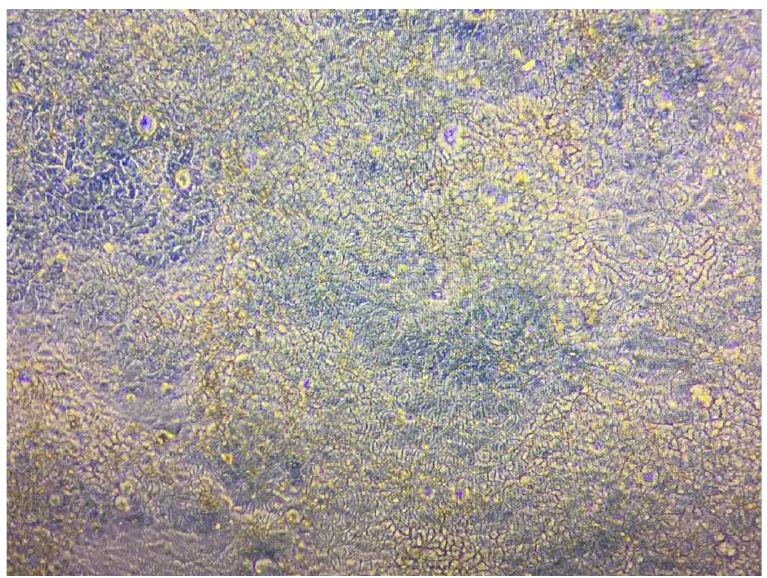
Figure 11. Light microscope image of a well-formed Caco-2 cell monolayer after 21 days of cell culture (20× magnification).